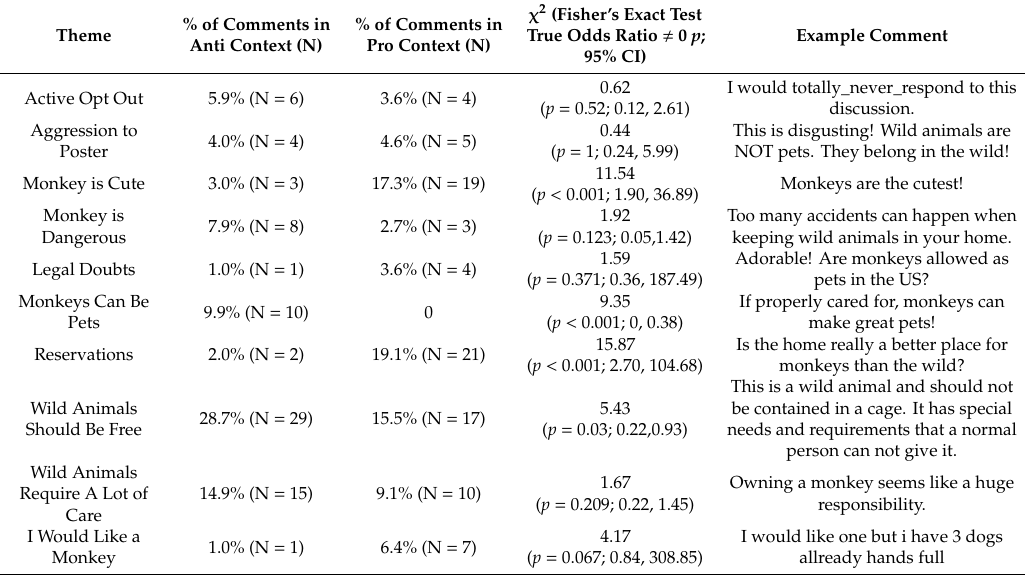
Table 4. Themes identified from participants’ responses to the Facebook discussion and differences between pro and anti primate pet keeping conditions.